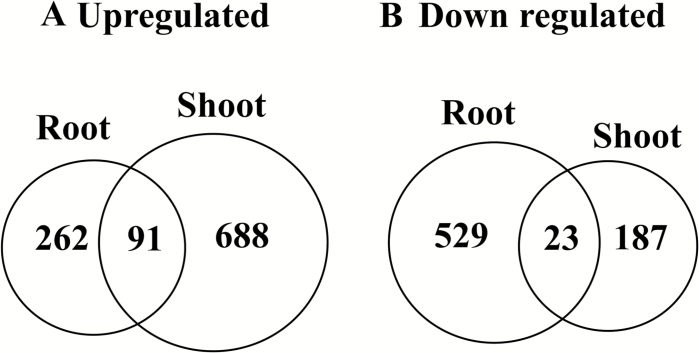
Summary of transcriptomic changes in mit-2 plants grown under control conditions. (A) Numbers of up-regulated genes identified in root and shoot tissues in mit-2 with respect to WT plants. (B) Numbers of down-regulated genes identified in root and shoot tissues in mit-2 with respect to WT plants